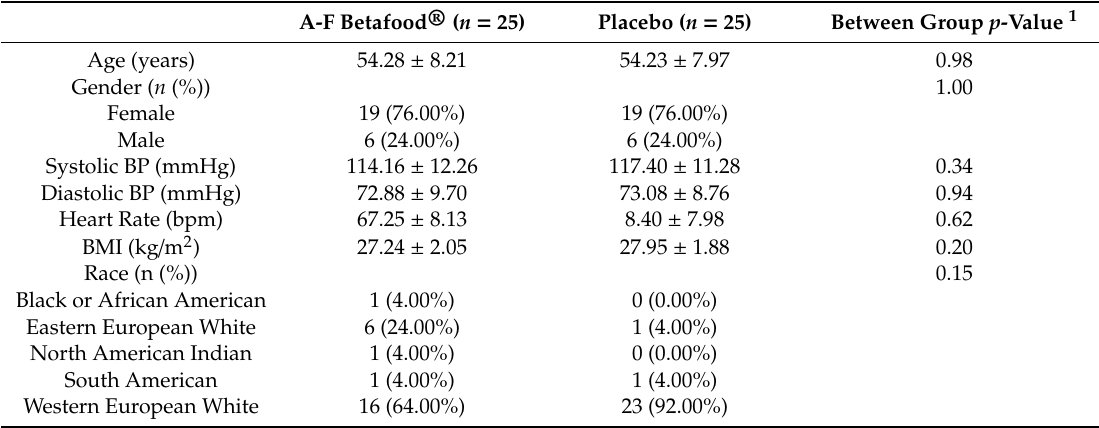
Table 1. Demographics for all participants enrolled (n =